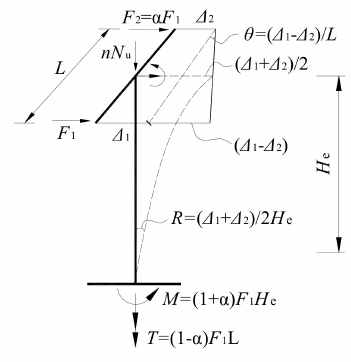
Figure 5. Loading